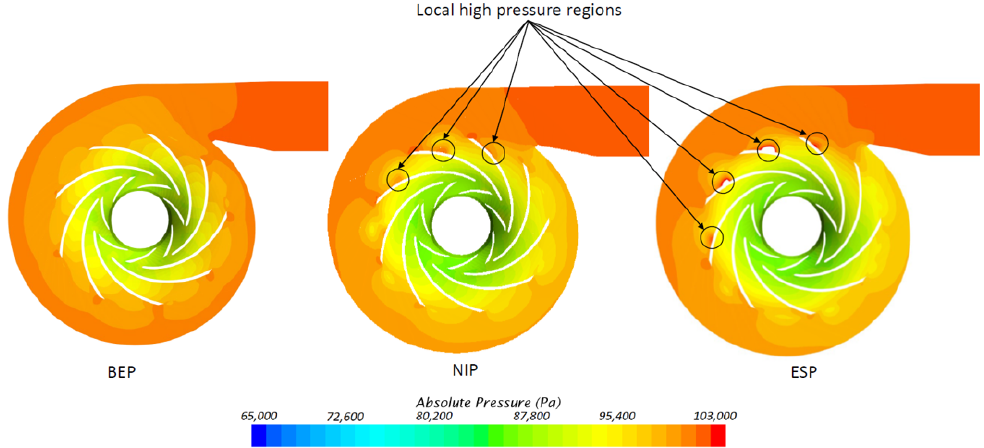
Figure 8. Pressure distribution on 0.5 span